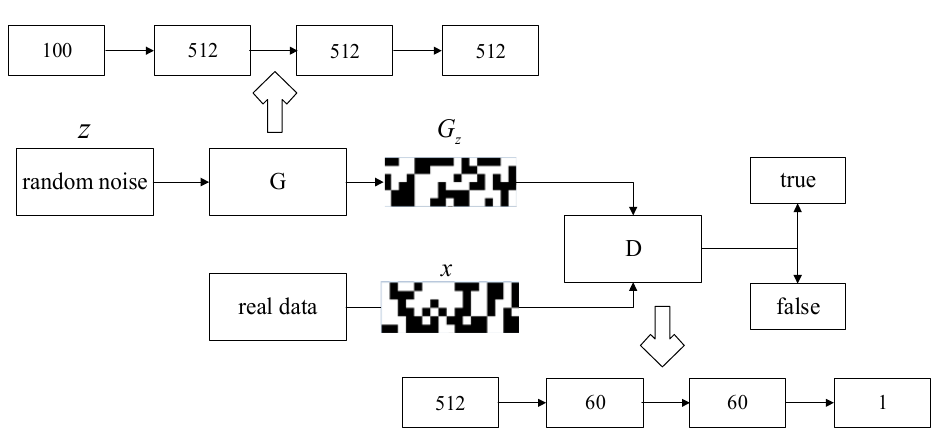
Figure 4. Specific framework diagram of GAN.